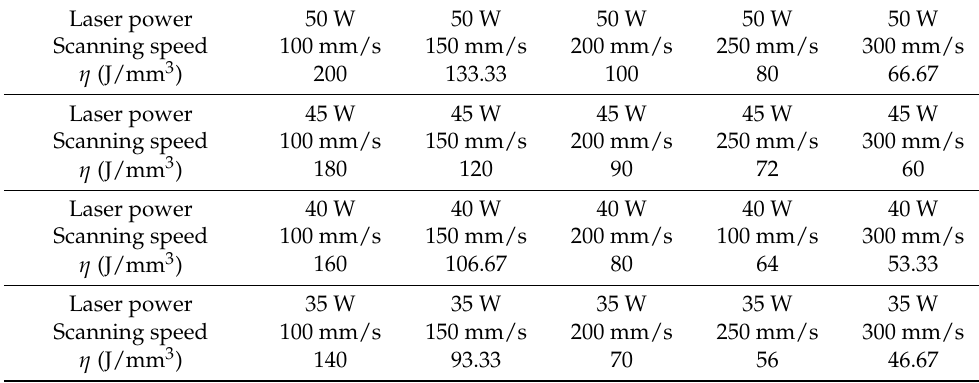
Figure 2. Laser scanning strategy and ISLF specimens: ( a ) “Zigzag” scanning strategy rotated by 90°; ( b ) ISLF samples. Table 1. Laser energy density η , corresponding to different process parameters.